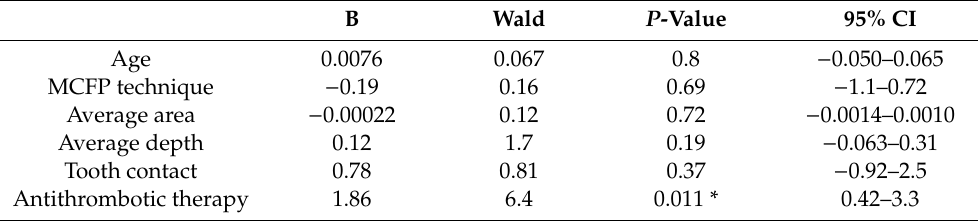
Table 3. Multivariate logistics regression about postoperative